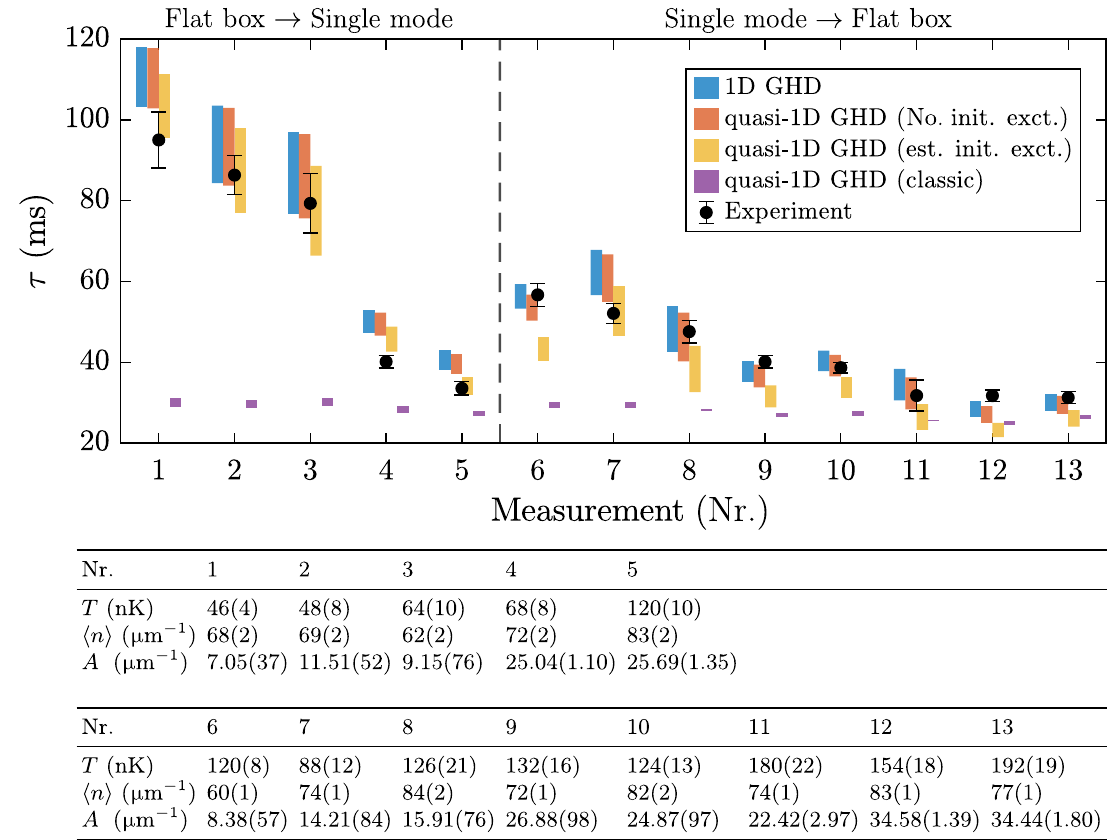
FIG. 10. Relaxation timescale of the first density mode. For both experimental measurements (points) and GHD simulations (shaded areas), the timescale τ is obtained by fitting the time evolution of the first density mode δ n 1 ð t Þ with the damped oscillation of Eq. (4). Four different GHD simulations are carried out: standard 1D GHD, quasi-1D GHD assuming no initial transverse excitations, quasi-1D GHD with an estimated thermal population of excited states, and quasi-1D GHD with a classical collision integral. The error bars of the experimental data points represent the 95% confidence interval of τ from fitting with Eq. (4). The extent of the shaded areas reflects the maximal variation in simulation results considering the uncertainties of both the mode amplitude A and temperature T listed in the table. The uncertainty of A is given by the 95% confidence interval from fitting with Eq. (4). The measured temperature T is inferred from density ripples analysis, and the corresponding uncertainties represent the 68% of confidence interval (more details can be found in Ref. [43]). All simulations assume a mean atomic density of 75 μ m − 1 in the box. Meanwhile, the measured mean atomic densities h n i obtained by averaging over multiple experimental realizations, and their uncertainties given by the standard deviation can be found in the table. Differences in mean density and effective box lengths between simulation and experiment are accounted for by scaling the experimental time